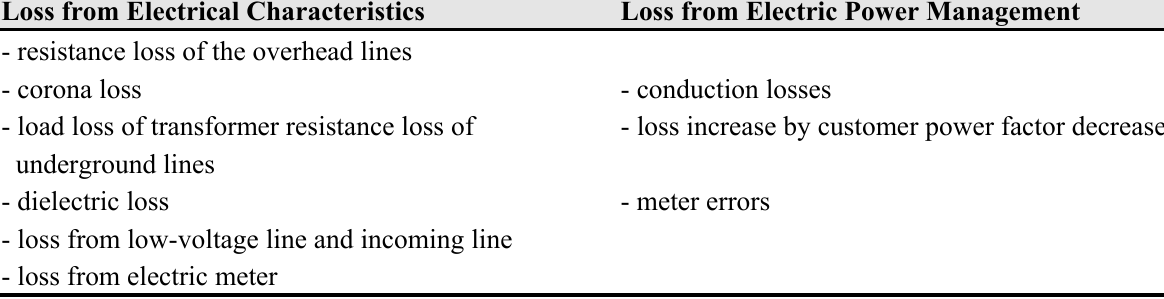
Table 1. Distribution Loss detail characteristics.